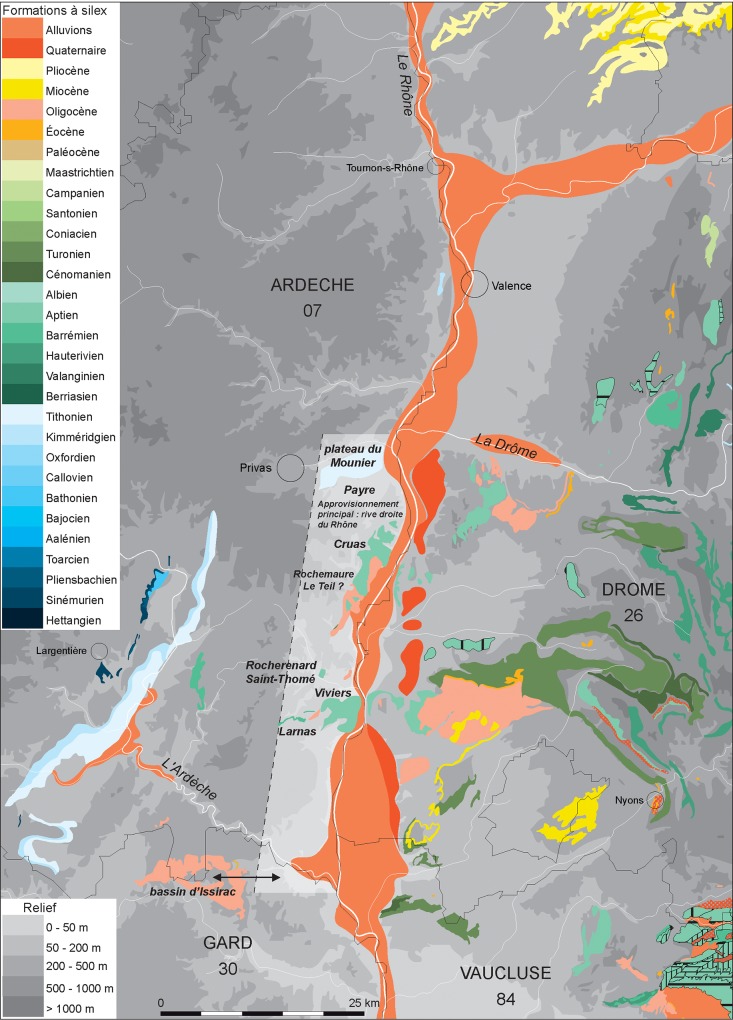
Map of the flint sources in level Gb at Payre.